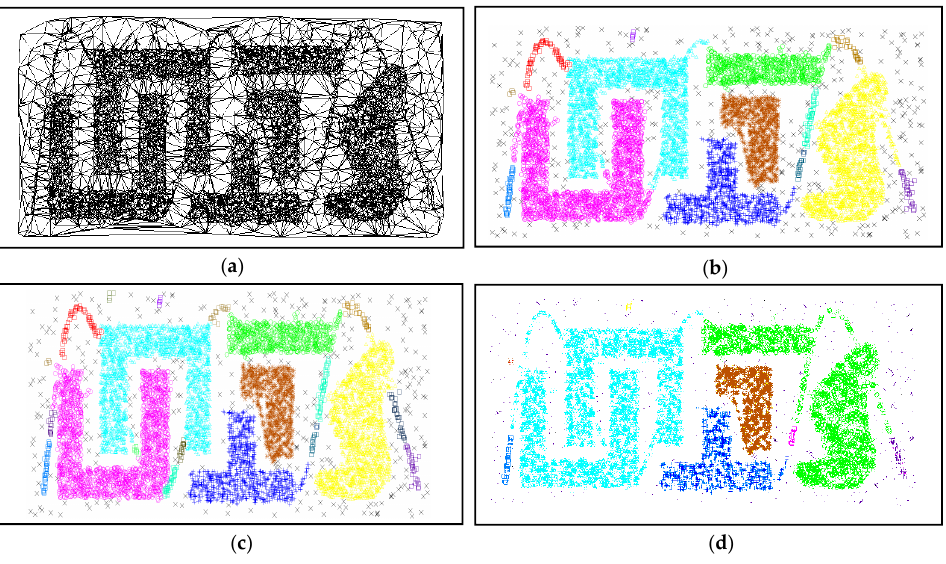
Figure 12. Results largely dependent on parameters: ( a ) Graph built by triangulation of D2; ( b ) 20 clusters obtained when α = 1; ( c ) 30 clusters obtained when α = 0.8; and ( d ) 8 clusters obtained when α = 1.2.